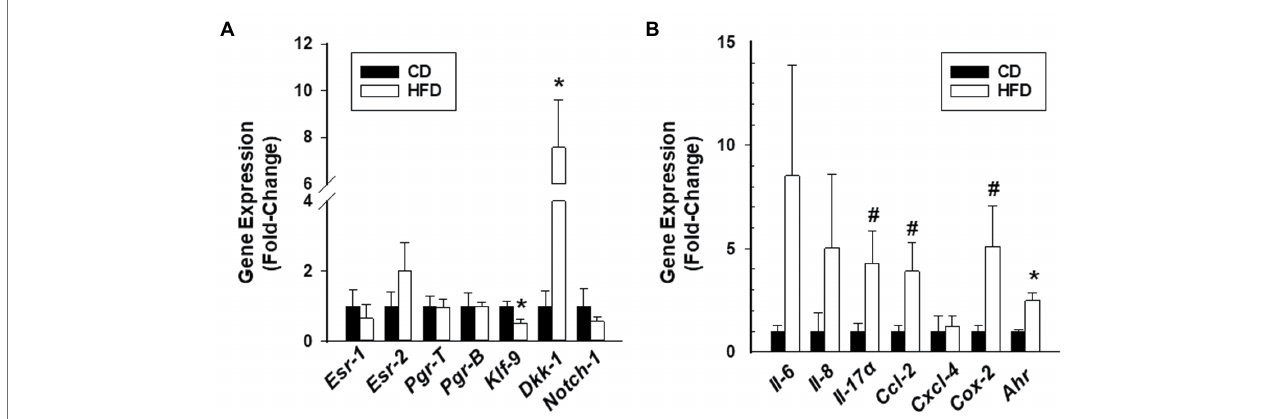
FIGURE 2 | Gene expression profiles of endometrial-like lesions from recipients fed CD or HFD. Lesions were evaluated for transcript levels of steroid hormone receptor signaling components (A) and cytokine/inflammation-associated genes (B) by QPCR. Data (mean ± SEM) are expressed as fold-change from CD lesion group and were obtained from n = 7 (CD) and n = 6 (HFD) lesions, with each lesion representing a different mouse. * p < 0.05 and # 0.10 < p < 0.05 by Student’s t- test.